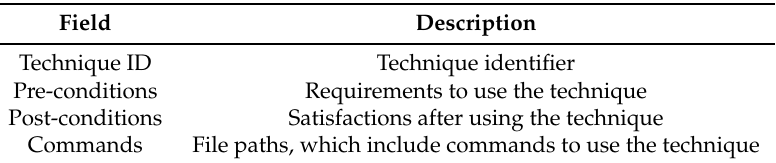
Table 2. Model of the attack